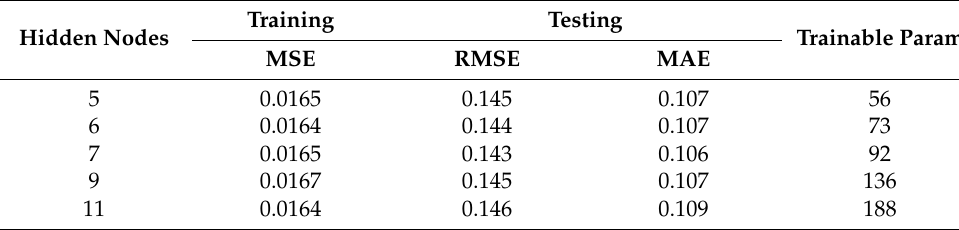
Table 15. Impact of hidden neurons on the performance of the model “RDM-2”.